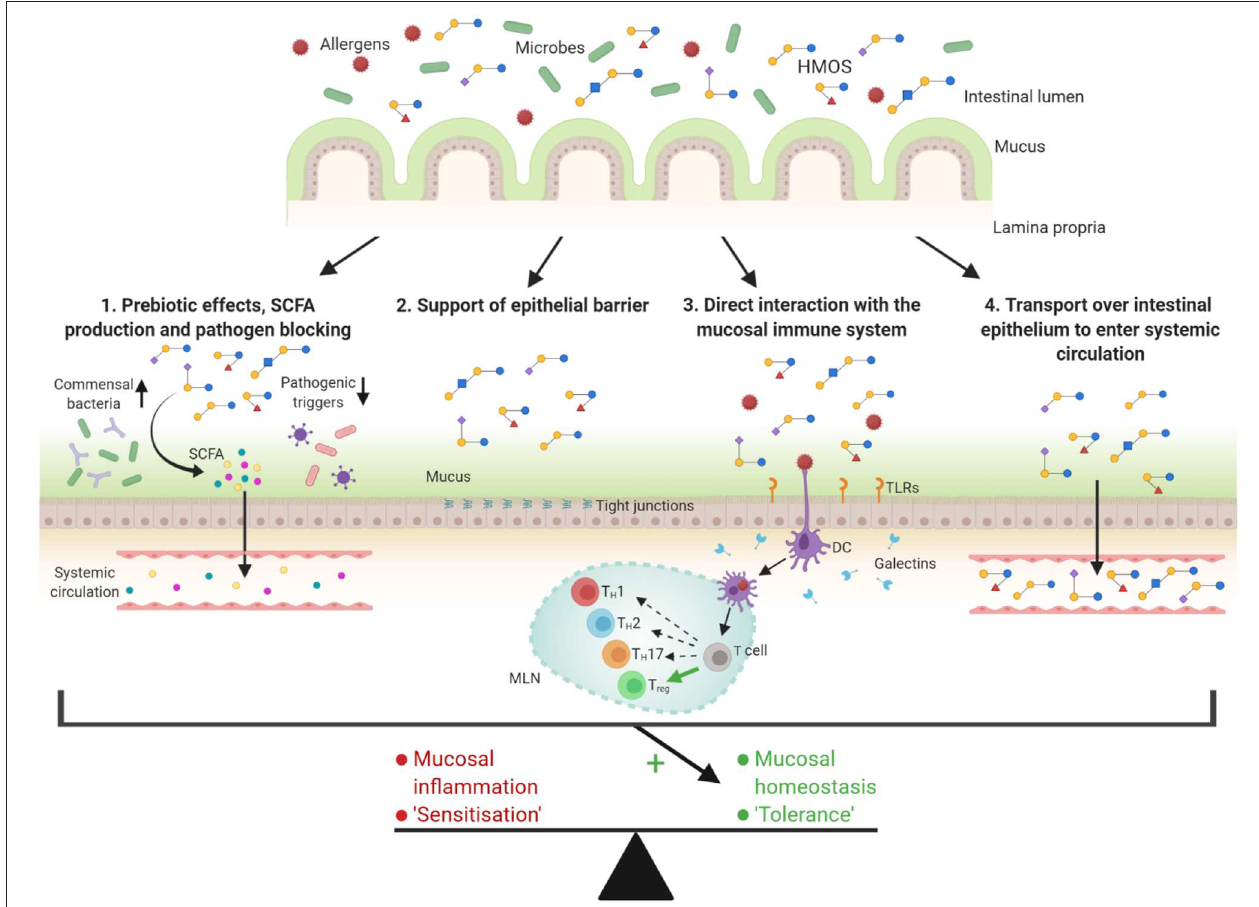
FIGURE 2 | Overview of the possible functions of HMOS related to the prevention of allergic diseases. The diversity in structures suggests engagement in several mechanisms related to maturation of the infant’s gastrointestinal tract. (1) HMOS have shown to function as prebiotics and therefore stimulate growth of commensal bacteria. In addition, HMOS have shown to bind pathogens, thereby preventing binding of these pathogens to the intestinal epithelium itself and possible consequent infections. SCFAs produced during HMOS fermentation can enhance epithelial barrier integrity and locally and systemically modify immune responses. (2) HMOS can promote mucus production and epithelial tight junction integrity, thereby supporting the physical barrier between the intestinal epithelium and the gut content. (3) Several mechanisms by which HMOS directly affect the immune function have been described. Modulation of the response of DCs is one of those described mechanisms which may be relevant for the instruction of protective mucosal immune development. (4) Transportation of a small fraction of HMOS over the intestinal epithelium, results in systemic availability of these structures. This suggests an immunomodulatory role for HMOS, also beyond the gastrointestinal tract. All these HMOS related mechanisms can potentially enhance tolerance induction and therefore possibly prevent allergic diseases. Adjusted from Ayechu-Muruzabal et al. (